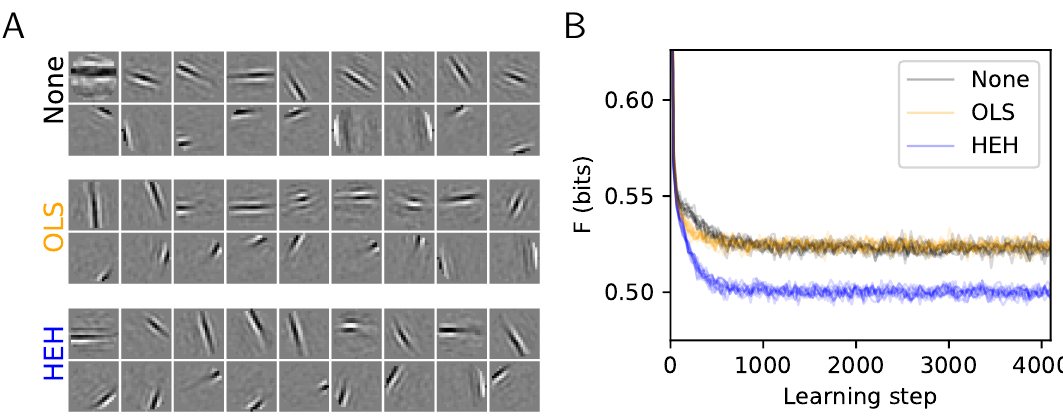
Figure 1. Role of homeostasis in learning sparse representations. This plot shows the results of the same Sparse Hebbian Learning algorithm at convergence (4096 learning epochs), but using different homeostasis algorithms. The compared algorithms are: None (using a simple normalization of the atoms), OLS (the method of the work by the authors of [10]), and HEH (using the optimal homeostasis rule described in this paper). ( A ) For each algorithm, 18 atoms from the N = 676 filters are shown. These are of the same size as the image patches ( M = 21 × 21 = 441, circularly masked) and presented in each matrix (separated by a white border). The upper and lower row respectively show the least and most probably selected atoms. This highlights qualitatively the fact that without proper homeostasis, dictionary learning leads to inhomogeneous representations. ( B ) Evolution of cost F (in bits, see Equation (6)) as a function of the number of iterations and cross-validated over 10 runs. Whereas OLS provides a similar convergence than None , the HEH method provides quantitatively a better final